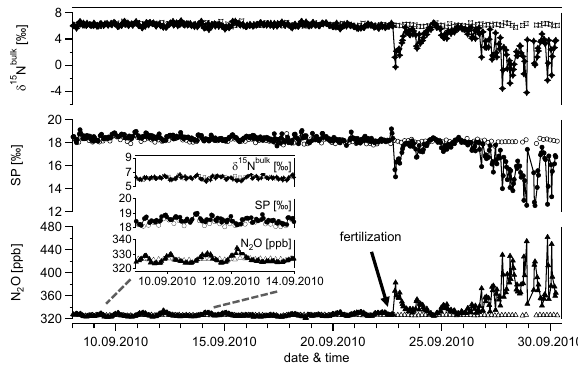
Fig. 3. Time series of N 2 O mixing ratio and the corresponding δ 15 N bulk and SP values of ambient air (closed symbols) and pres- surized air (target gas, open symbols) analysed by QCLAS after preconcentration. Relative isotope ratio differences are based on the Tokyo Tech calibration of the primary laboratory standards. Strong emissions of 15 N depleted N 2 O were observed after fertiliser ad- dition (200kg-Nha − 1 NH 4 NO 3 , 400kg-Cha − 1 sucrose) indicated by an arrow.